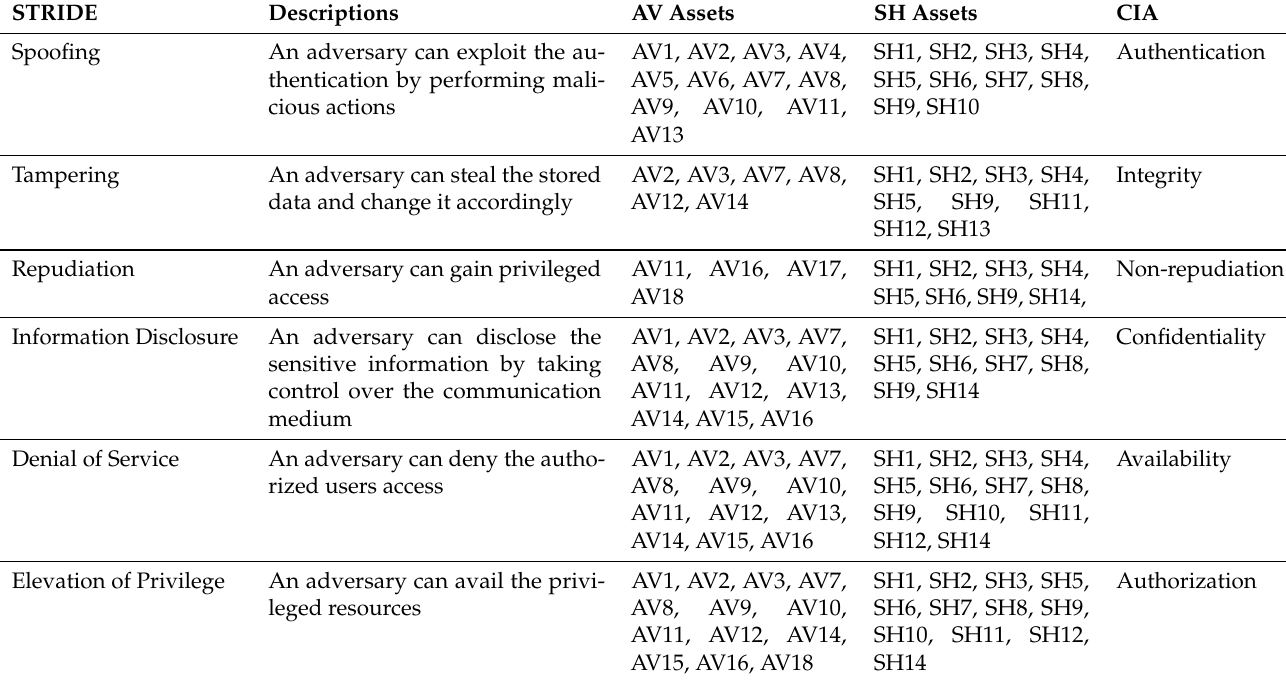
Table 4. STRIDE Threats Mapping in both Use